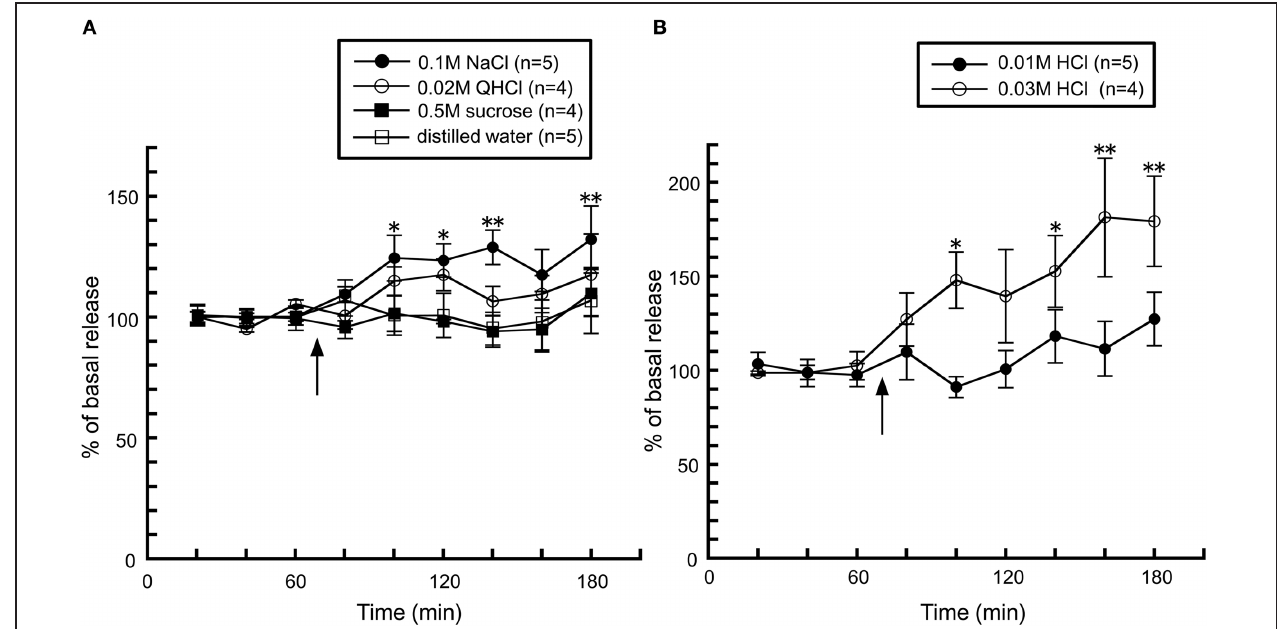
time point of taste stimuli. The mean values of the three baseline samples preceding taste stimuli were taken as 100%. Values are presented as percentages of the mean basal release ± SEM ∗∗ p < 0 . 01, ∗ p < 0 . 05 compared with the basal release of each group, respectively.